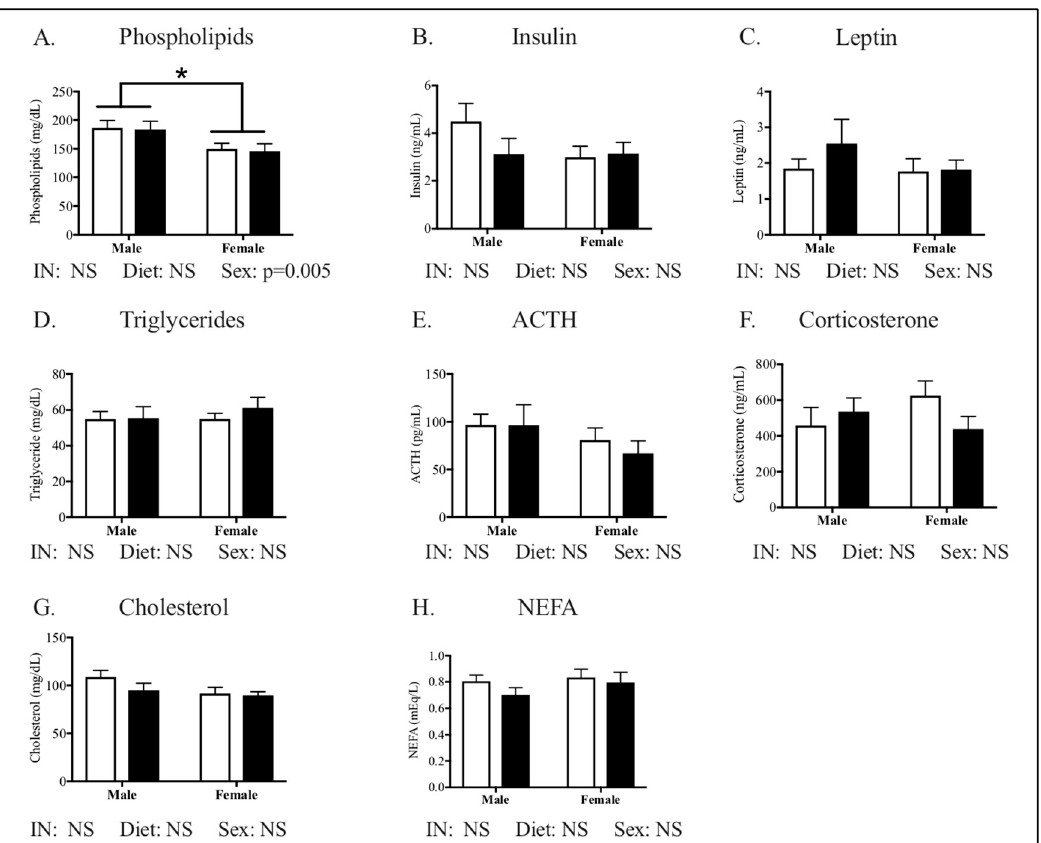
Figure 3. Metabolic profile in peripubertal offspring following maternal HFHC-diet-induced obesity. Plasma phospholipids (Panel A ), insulin (Panel B ), leptin (Panel C ), triglycerides (Panel D ), adrenocorticotropic hormone (Panel E ), corticosterone (Panel F ), cholesterol (Panel G ), and non-esterified fatty acids (Panel H ) were measured in fasted male and female offspring, following weaning from CON and HFHC dams. There were no significant differences between groups in either male or female offspring. Females had lower phospholipid concentrations than males (Panel A , p = 0.005). ACTH—adrenocorticotropic hormone; NEFA—non-esterified fatty acids; CON—offspring born to dams maintained on control diet; HFHC—offspring born to dams maintained on high-fat-high-carbohydrate diet. Open bars represent CON offspring; closed bars represent HFHC offspring; Results are expressed as mean ± SEM; two-way ANOVA, n = 12–15 group, vs. offspring born to dams consuming same diet (diet effect) vs. male offspring born to dams consuming different diets (sex effect); * p < 0.05, p values > 0.1 were recorded as non-significant (NS).